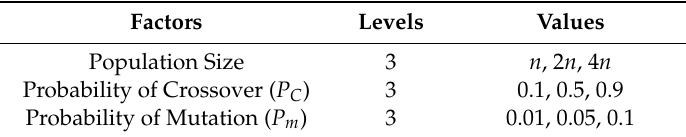
Table 1. Experimental factors and their